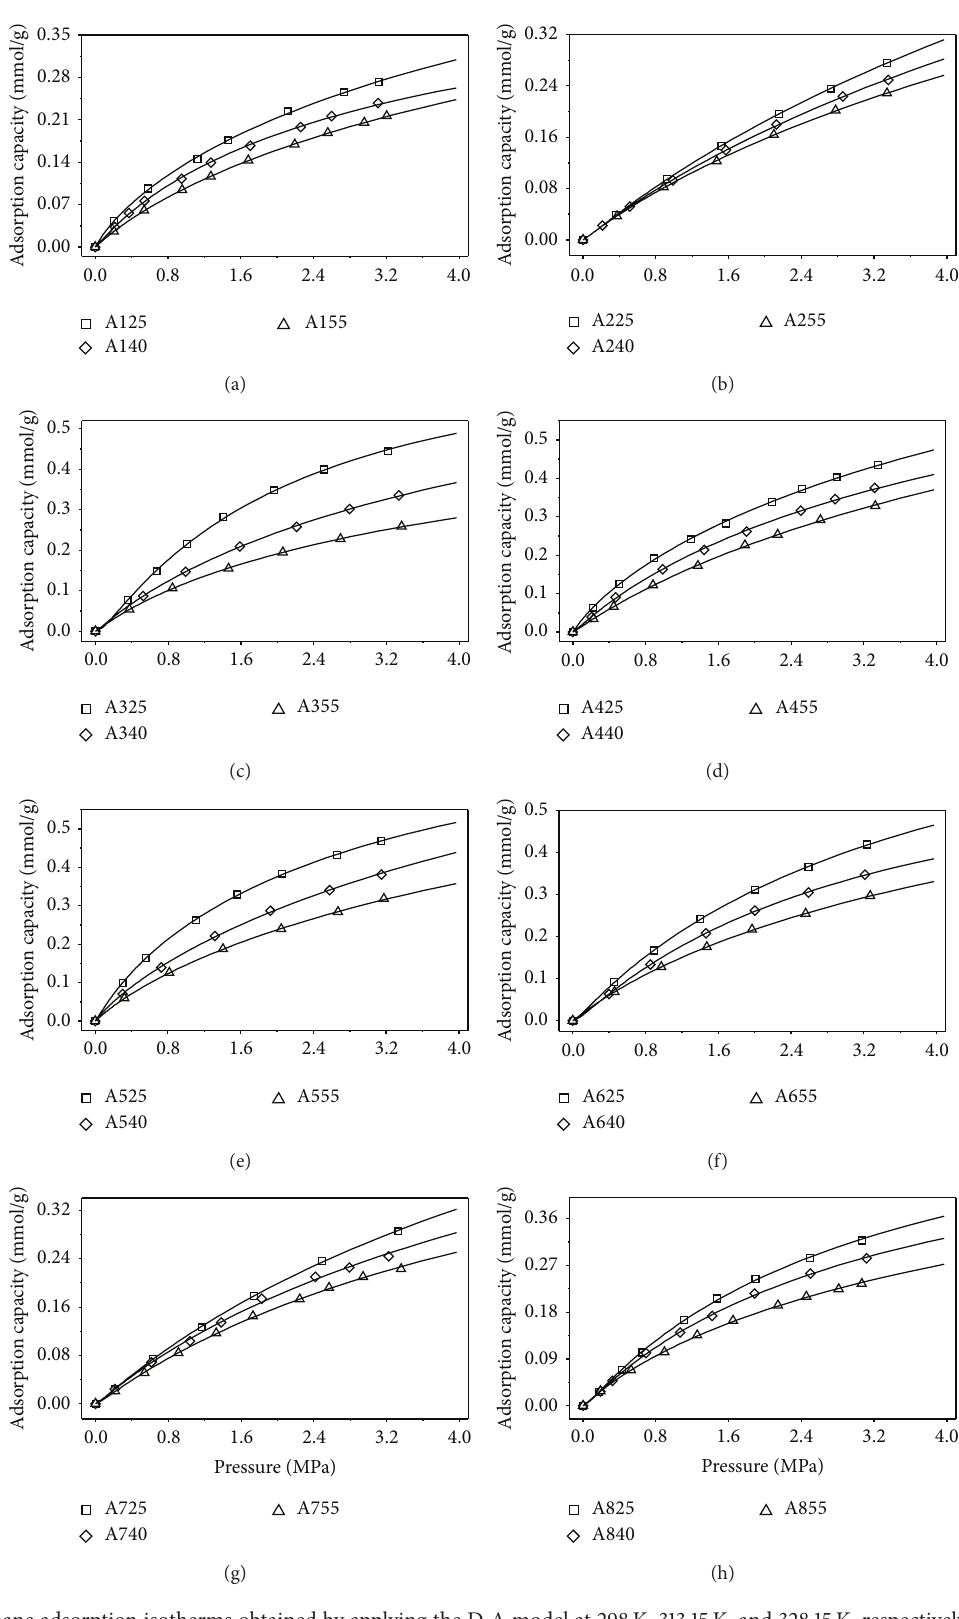
Figure 4: Methane adsorption isotherms obtained by applying the D-A model at 298 K, 313.15 K, and 328.15 K, respectively. (a) A1, (b) A2, (c) A3, (d) A4, (e) A5, (f) A6, (g) A7, and (h) A8; solid line, fitted by the D-A